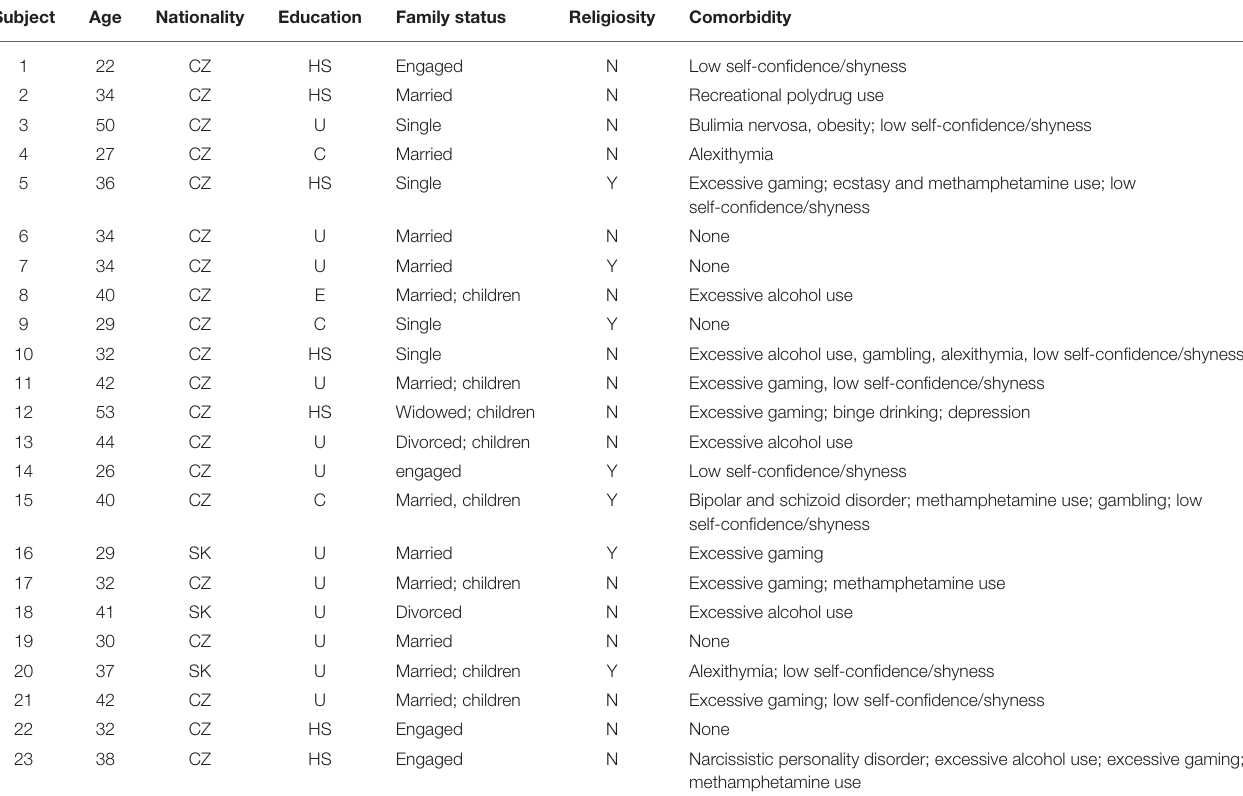
TABLE 1 | Key characteristics of the